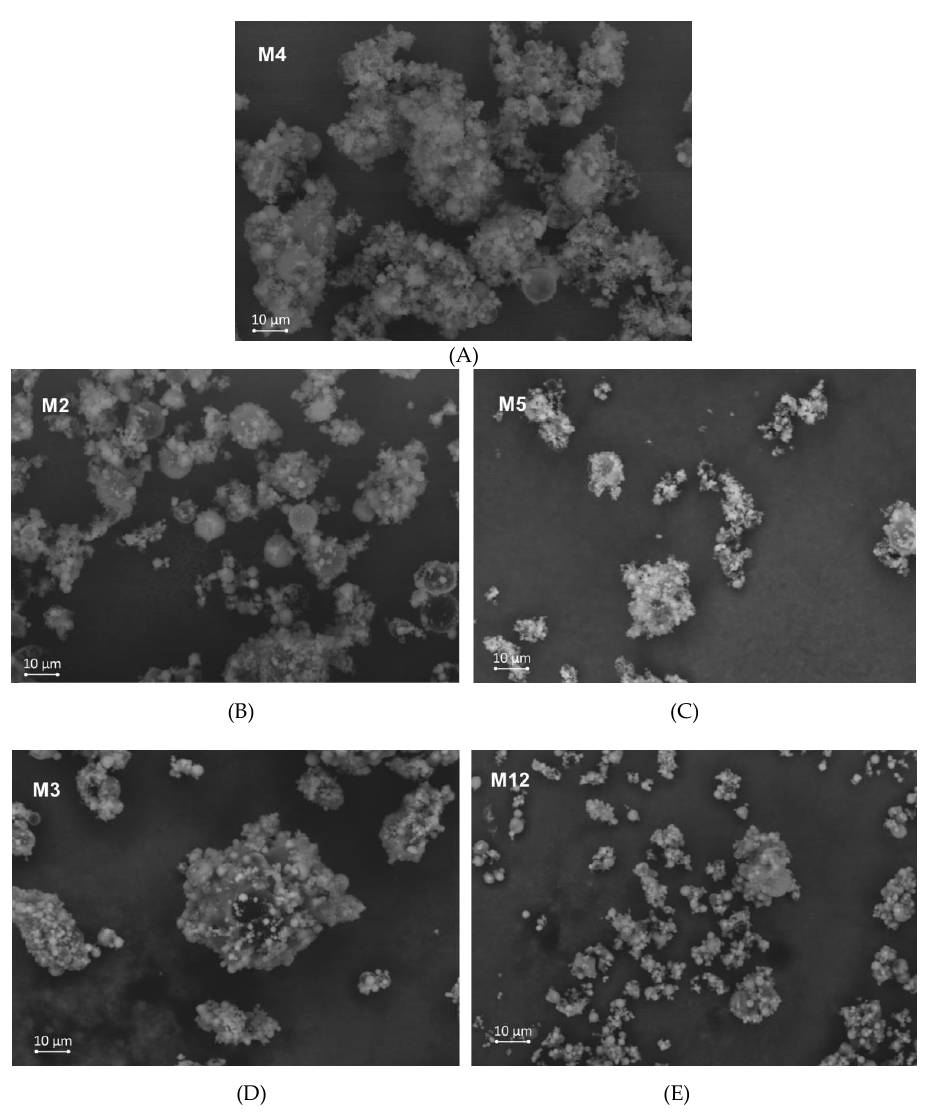
Figure 3. SEM images of zidovudine (ZVD)-loaded microparticles with chitosan glutamate and beta-glycerophosphate disodium in a ratio 3:1: M4 ( A ); 2:1: M2 ( B ) and M5 ( C ); 1:1: M3 ( D ) and M12 ( E ); original magnification ×2000.